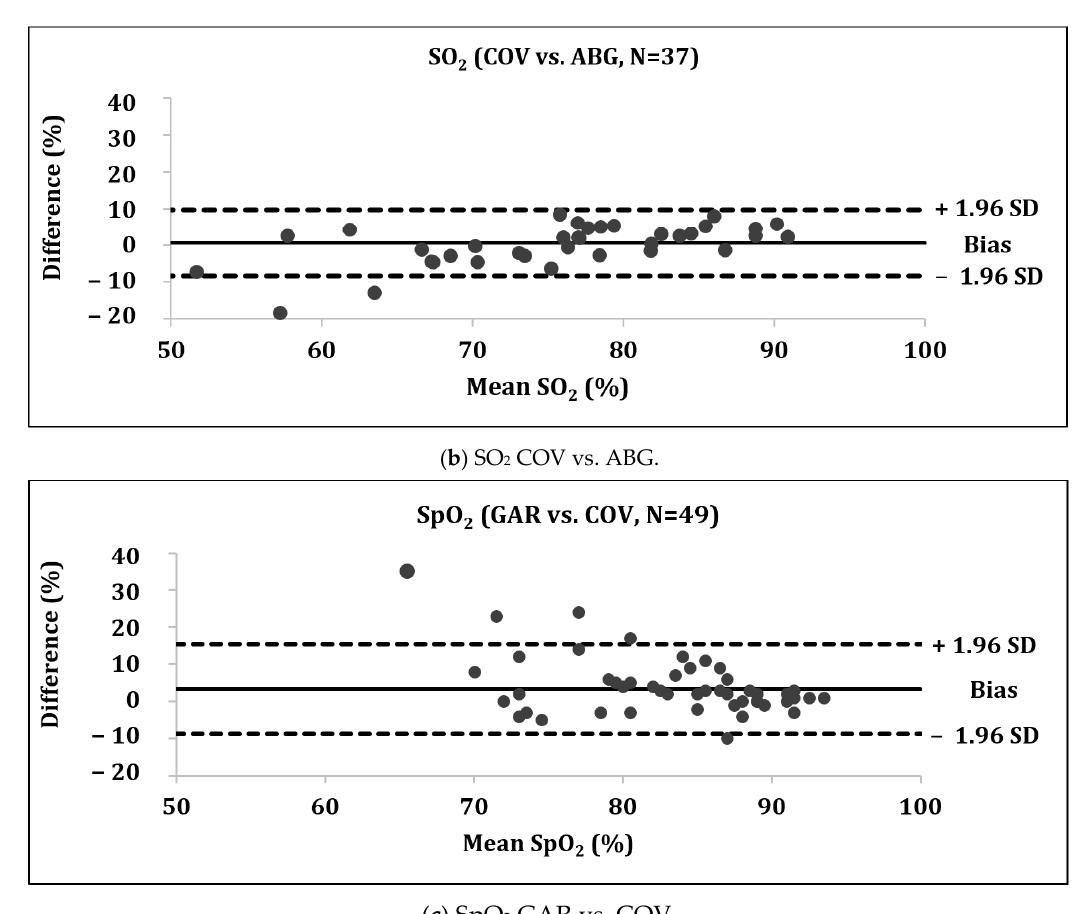
Figure 3. ( a – c ) Bland–Altman analysis with mean difference and limits of agreement. SO 2 = peripheral/arterial oxygen saturation; GAR = Garmin F ē nix ® 5X Plus; ABG = Radiometer ABL 90 Flex. COV = Covidien Nellcor Portable SpO 2 Patient Monitoring. Data given in mean ± SD.